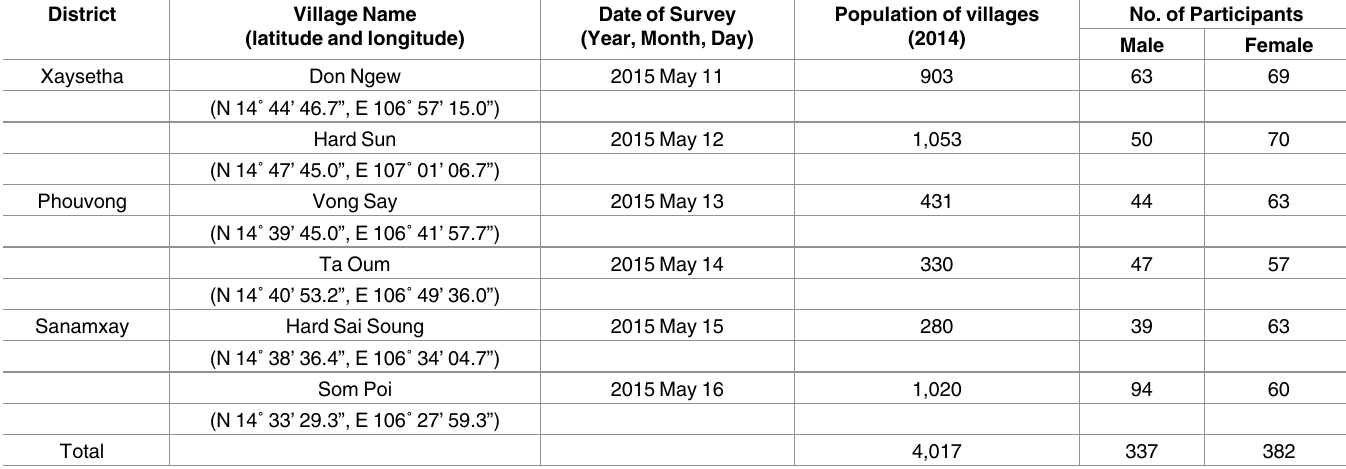
Plasmodium prevalence by the three diagnostic methods